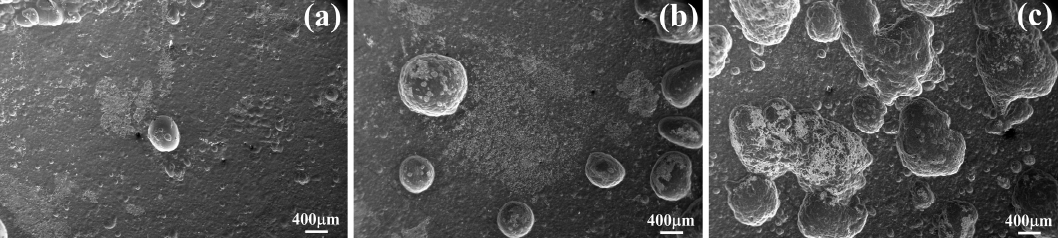
Figure 11. Surface morphologies after removing corrosion products: ( a ) Mg − 1Sn − 1Zn − 0.5Ca; ( b ) Mg − 3Sn − 1Zn − 0.5Ca; ( c ) Mg − 5Sn − 1Zn − 0.5Ca.